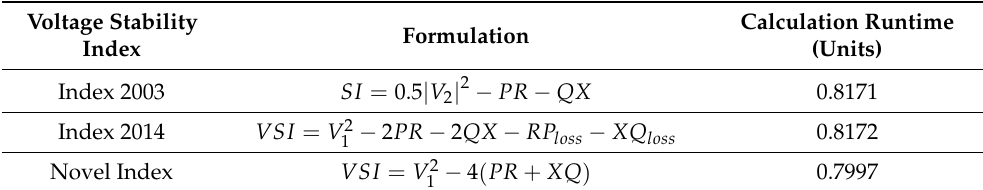
Table 3. Comparison of the assessed voltage stability